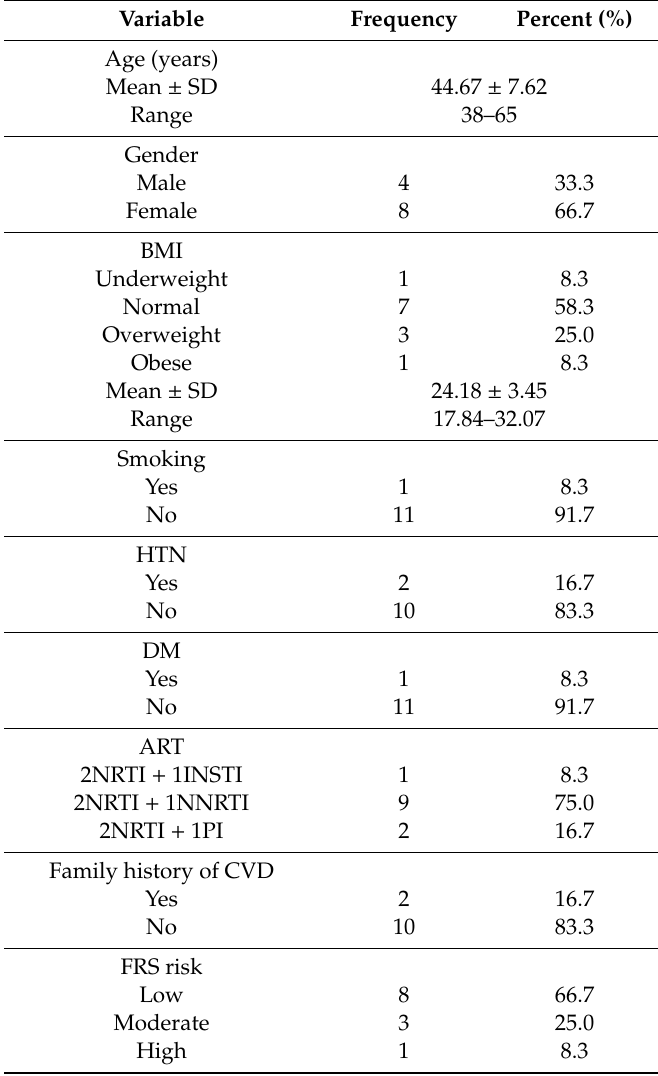
Table 1. Demographic and clinical variables of the study